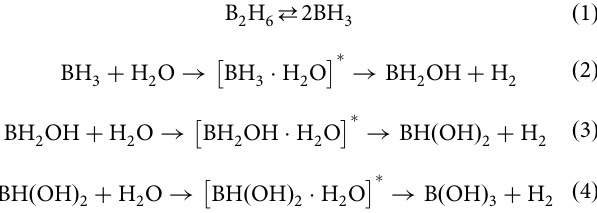
Fig. 1 Reaction of water and HB sheets. a H 2 amount as a function of time from the mixture of HB (58.04 mg) and distilled water (20 mL), where water (50 mL) was added at 400min. b XPS B1s spectra after drying the mixture of water (10 mL) with HB (1.2 – 21.9 mg). c B1s (193 eV) peak component as a function of the HB amount in the B1s spectra shown in ( b ), inset shows the photograph of the sample after drying the mixture of HB and water at 393